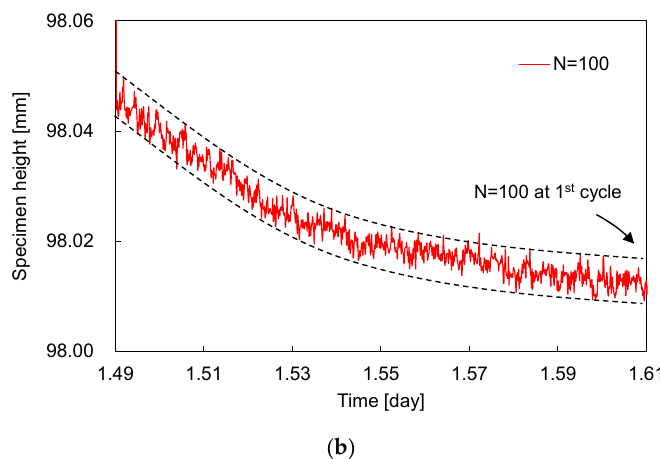
Figure 4. Variation of specimen height for SF = 70% mixture during: ( a ) cyclic freezing-thawing- repetitive loading under N = 1, 100, and 1000; ( b ) repetitive loading of N = 100 at 1st cycle. N denotes the number of repetitive loading.